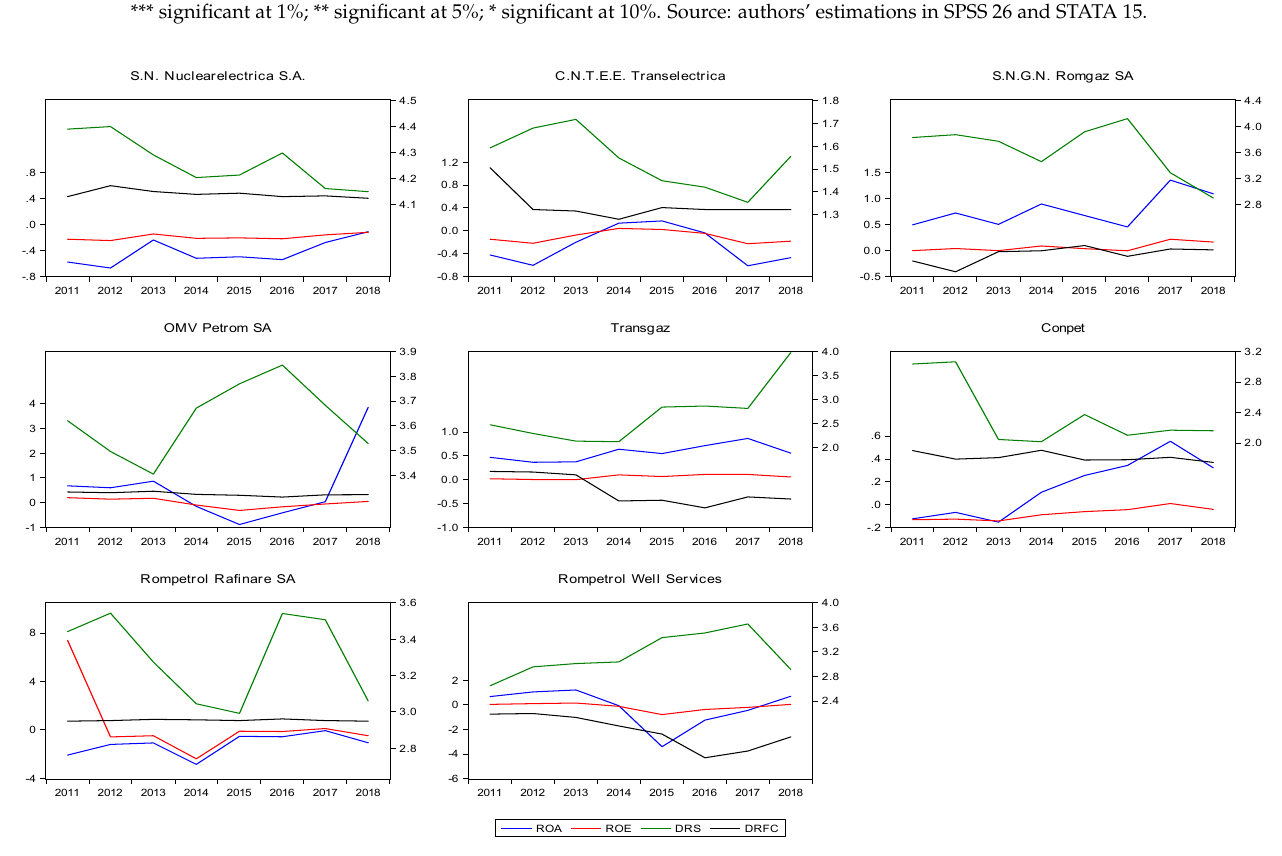
Figure 4. ROA, ROE, DRFC (left axis) and the DRS (right axis). Source: authors’ construction in Eviews 7. It can be seen from Figure 4 the uncorrelated and unrelated evolution of ROA and ROE on the one hand, and the duration of inventory rotation and the gap between the payment period of suppliers and the duration of receivables collection on the other hand. In comparison with the FNTREZEXPL, which is significantly influenced by the DRS, neither ROA nor ROE is. The DRS has no effect upon performance in terms of income for the evaluated energy companies. Another important difference is the fact that, regardless of the specification, productivity is always significant with a positive coefficient, as ex- pected. The difference between the DRF and DRC is positively related to ROA but only in the initial model or in the presence of AI. When the turnover is included in the model, its significance disappears. The second performance indicator in terms of income, ROE, does not have any relationship with the DRF_C. Table 5. Regression results—ROA and ROE as endogenous (robust Equation (1) respecified and with control factors Equation (2) respecified). Variables